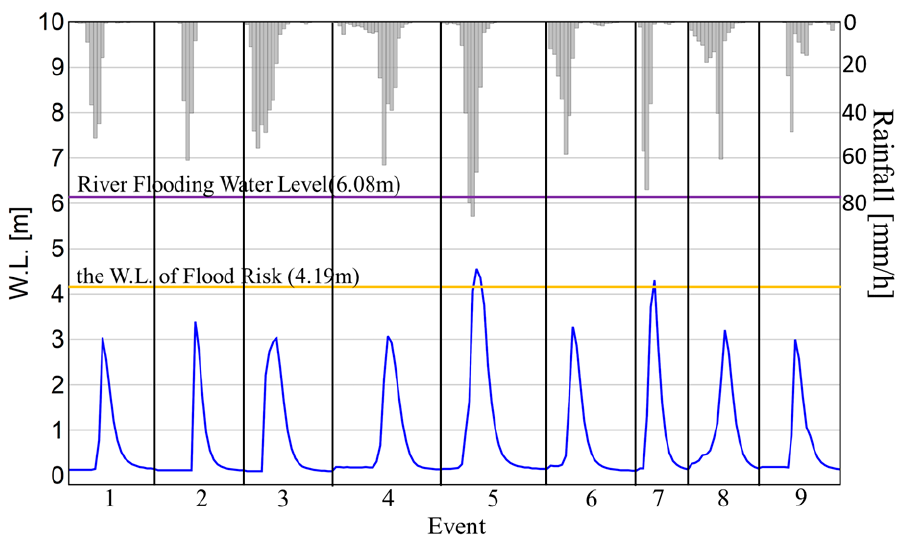
Water 2023 , 15 , x FOR PEER REVIEW Figure 3. Localized torrential rainfall events since 2015 (9 Events). Figure 3. Localized torrential rainfall events since 2015 (9 Events).